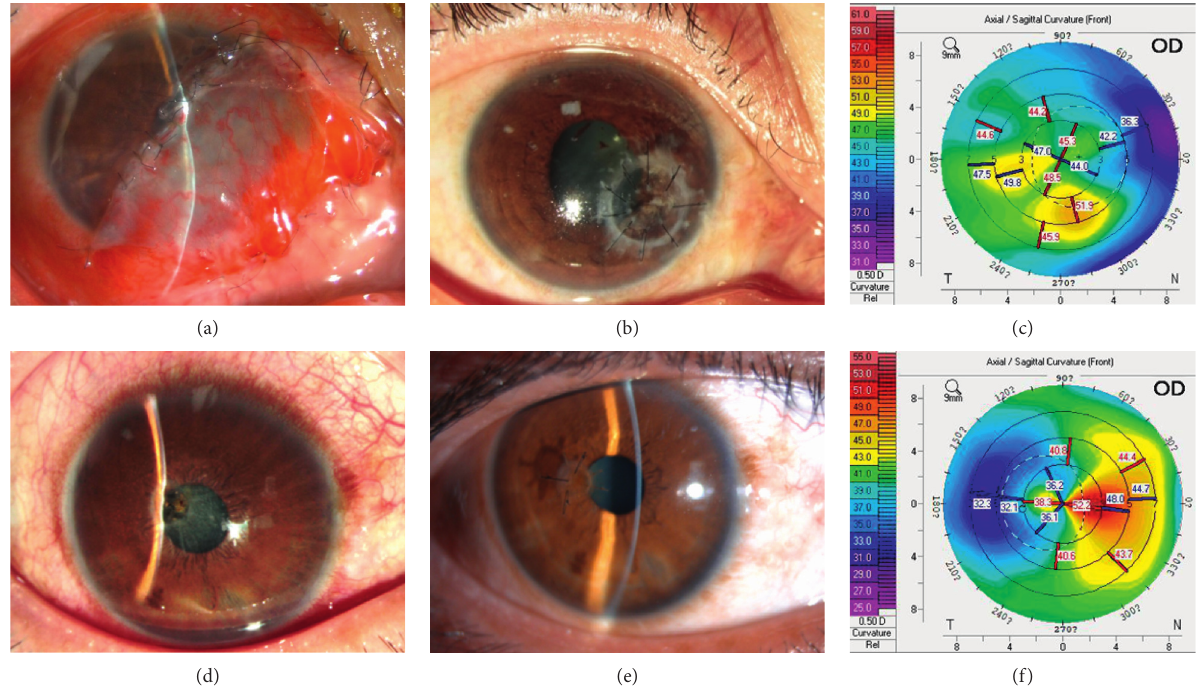
Figure 6: Penetrating keratoplasty and corneal patching for corneal perforation. (a–c) Penetrating keratoplasty with a cylindrical graft of 3.5mm in diameter. (a) Half of the cornea is covered by a conjunctival flap, and the anterior chamber disappears, with UCVA being hand movement. (b–c) Eight months after surgery, corneal edema is alleviated greatly, the UCVA is 1.0 logMAR, and the curvature of the front cornea is 47.3/47.7. (d–f) Penetrating corneal patching with a conical graft. (d) Corneal perforation at the central cornea, with no anterior chamber, and the UCVA being 1.22 logMAR. (e–f) 12 months after surgery, the corneal patch is transparent, the UCVA is 0.40 logMAR, and the curvature of the front cornea is 38.7/44.5.